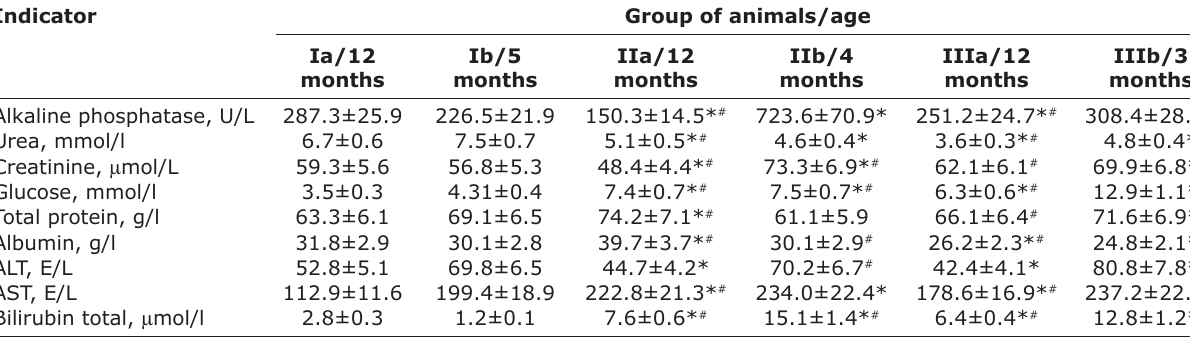
Table-6: Biochemical indices of rat blood (experiment of 6 months).